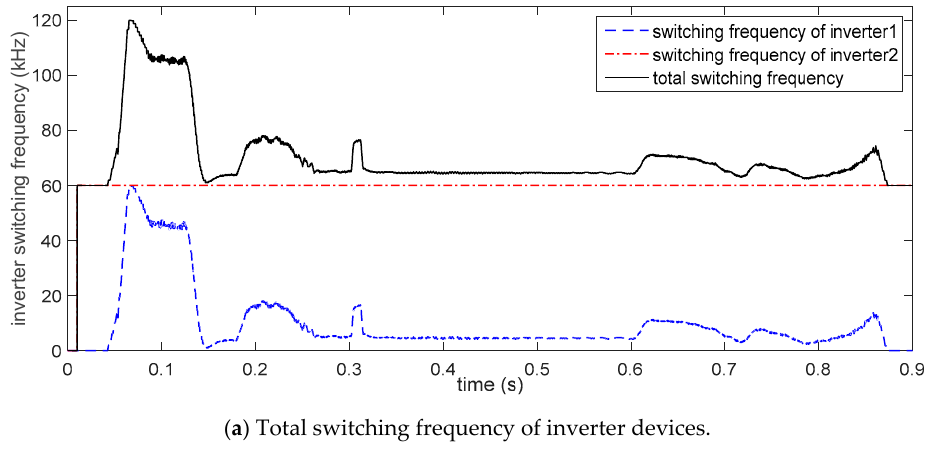
Figure 16. Inverter voltage vector distribution in static DQ plane.